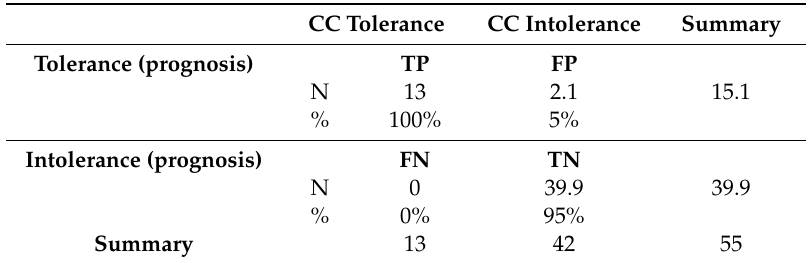
Table 4. Sensitivity and specificity of CC calculated for a cut-o ff point of 0.322. CC Tolerance CC Intolerance Summary Tolerance (prognosis) TP FP